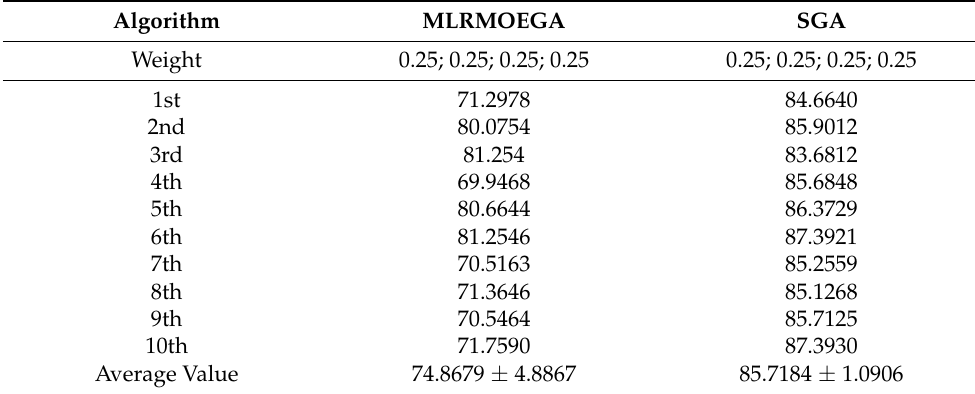
Figure 22. The paths of 30 × 30 grid map generated by: ( a ) MLRMOEGA; ( b ) SGA. Table 13. The results of test (30 × 30 grid